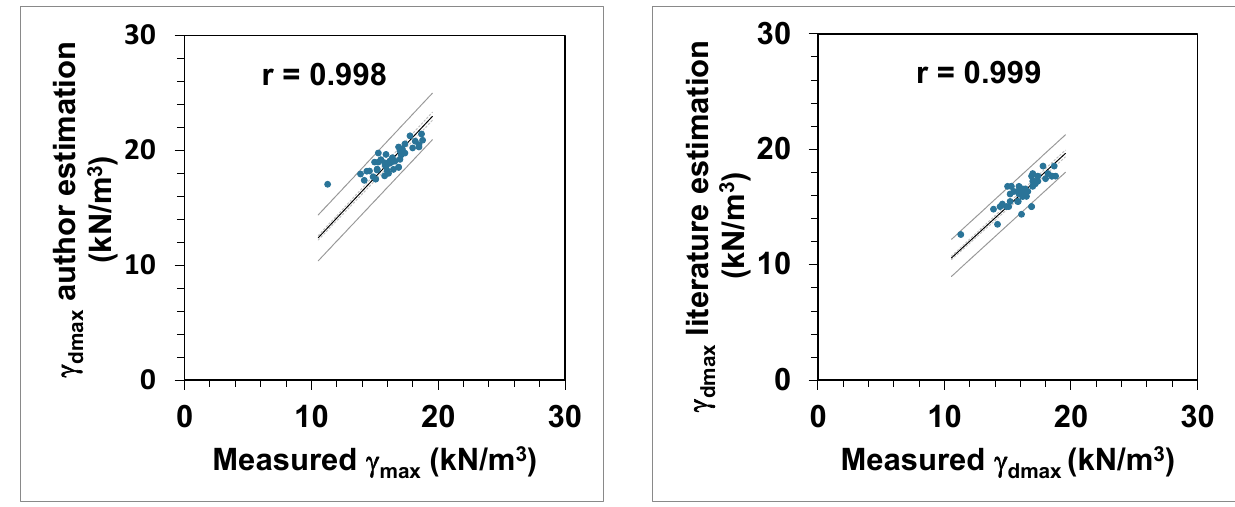
Figure 5. Correlation between measured literature data [30] and estimated γ dmax using the literature estimation [30] and author equations.